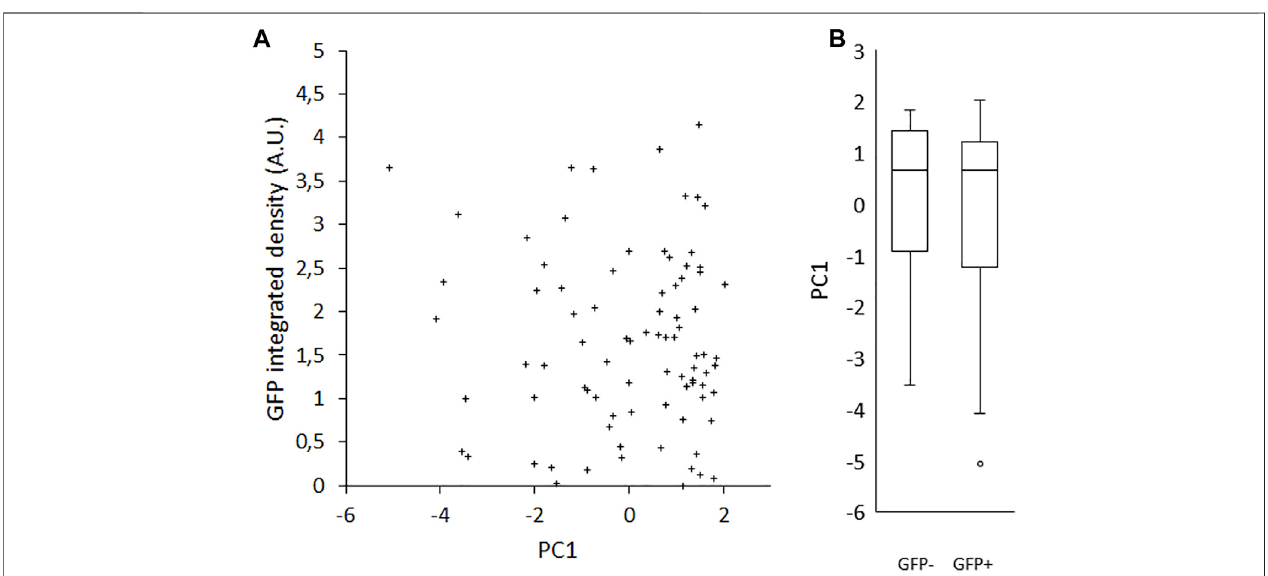
FIGURE 4 | Effect of Rex1-GFP expression on morphological index (PC1). Rex1-GFPd2 cells were cultured in LIF/FBS medium for 6 h and imaged live. Morphological traits were measured from phase contrast images and reduced by principal components analysis to a single metric, PC1, compared here to GFP fl uorescence integrated density from the same cells. There is no correlation between PC1 and the intensity of GFP expression from the Rex1 promoter ( A , R = − 0.069). Thisisalsore fl ectedintheindividualvalueplotofsub-median( − )vs.super-median(+)GFPintegrateddensityagainstPC1 (B) .Thereisnoapparentdifferenceinthe distribution of the two groups, which implies that there is no relationship between Rex1 expression and cell morphology. Median GFP I.D. = 1.50023 A.U., GFP+ and GFP-denotecellsabove orbelowmedian, respectively. Boxes represent median andinterquartilerange, withwhiskers extendingto1.5× interquartile rangeorthemax/ min data points. n =